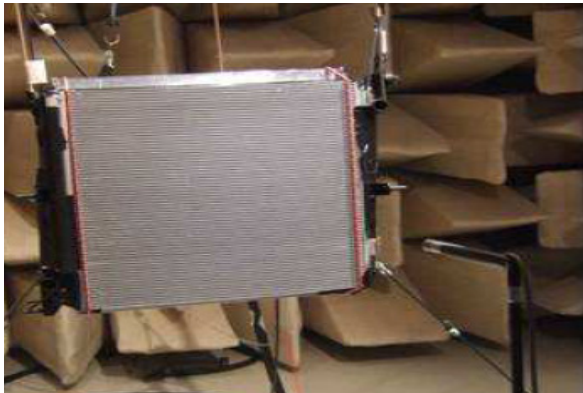
Figure 4. Semi-anechoic chamber, with the cooling module hanged and microphone positioning.